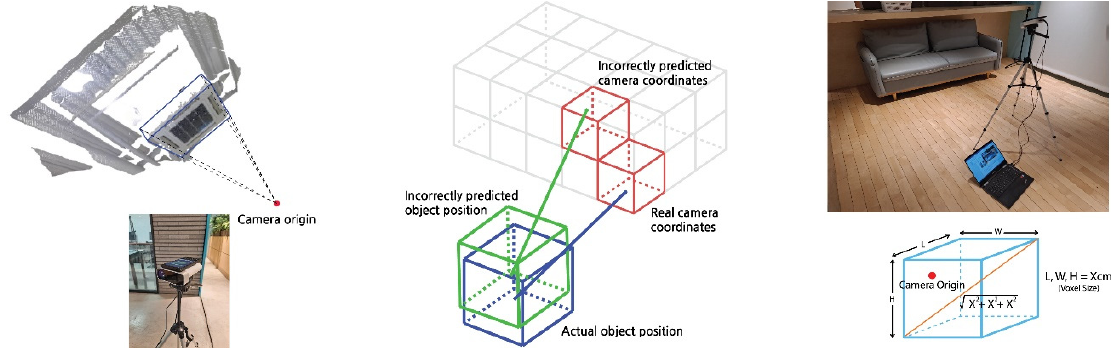
Figure 9. Visual positioning system (VPS) error and measurement.